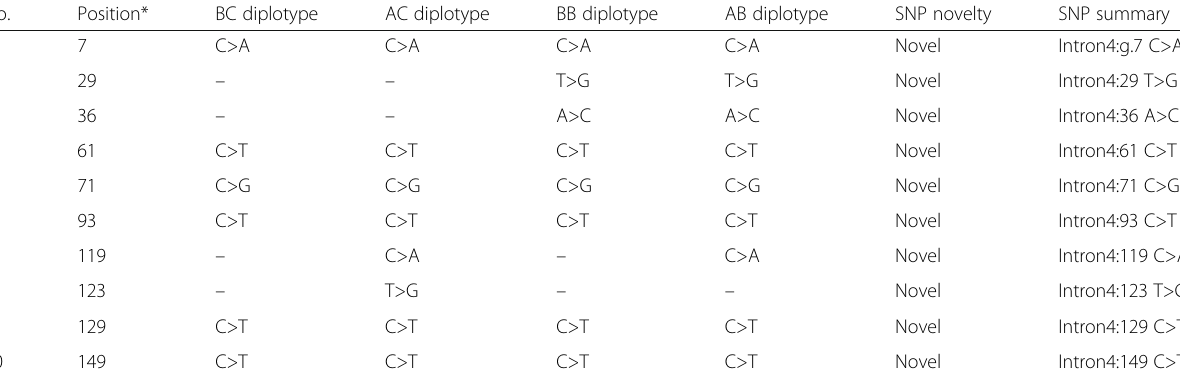
Table 1 List of all single nucleotide polymorphisms observed in the SSCP diplotyped GHRL 262-bp amplicons in both sheep and goats No.